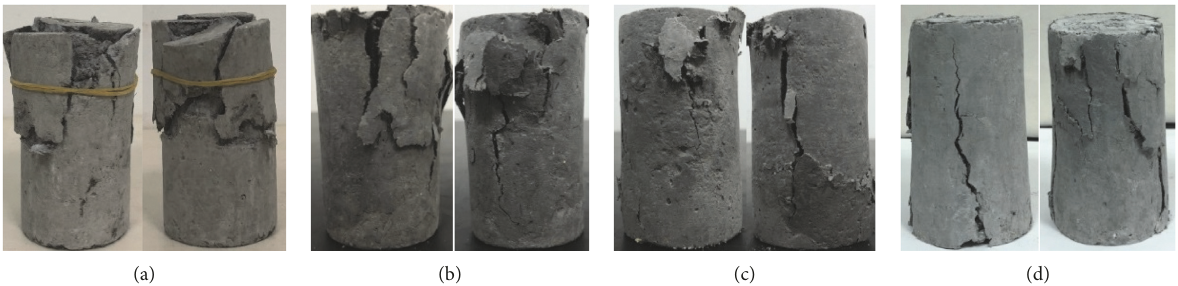
Figure 12: Failure modes under uniaxial compression tests: (a) initial state; (b) 30 day; (c) 90 day; (d) 150 day.